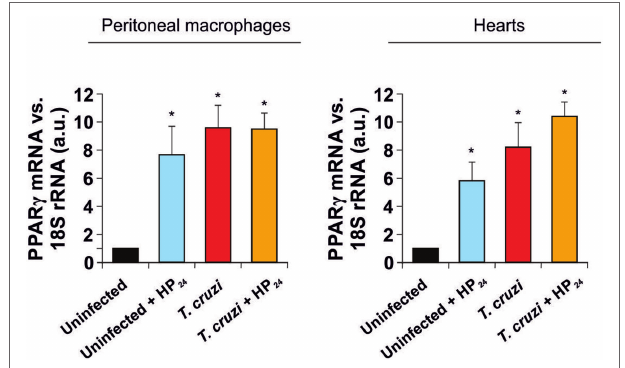
FigUre 2 | Peroxisome proliferator-activated receptor gamma (PPAR γ ) expression. PPAR γ mRNA expression was analyzed by quantitative real-time reverse-transcriptase polymerase chain reaction in peritoneal macrophages and heart homogenates from uninfected and Trypanosoma cruzi -infected mice, treated or not with HP 24 . Results were normalized against 18S rRNA. Results represent the mean ± SEM of three independent experiments (five mice per group). * P < 0.05 vs. uninfected mice